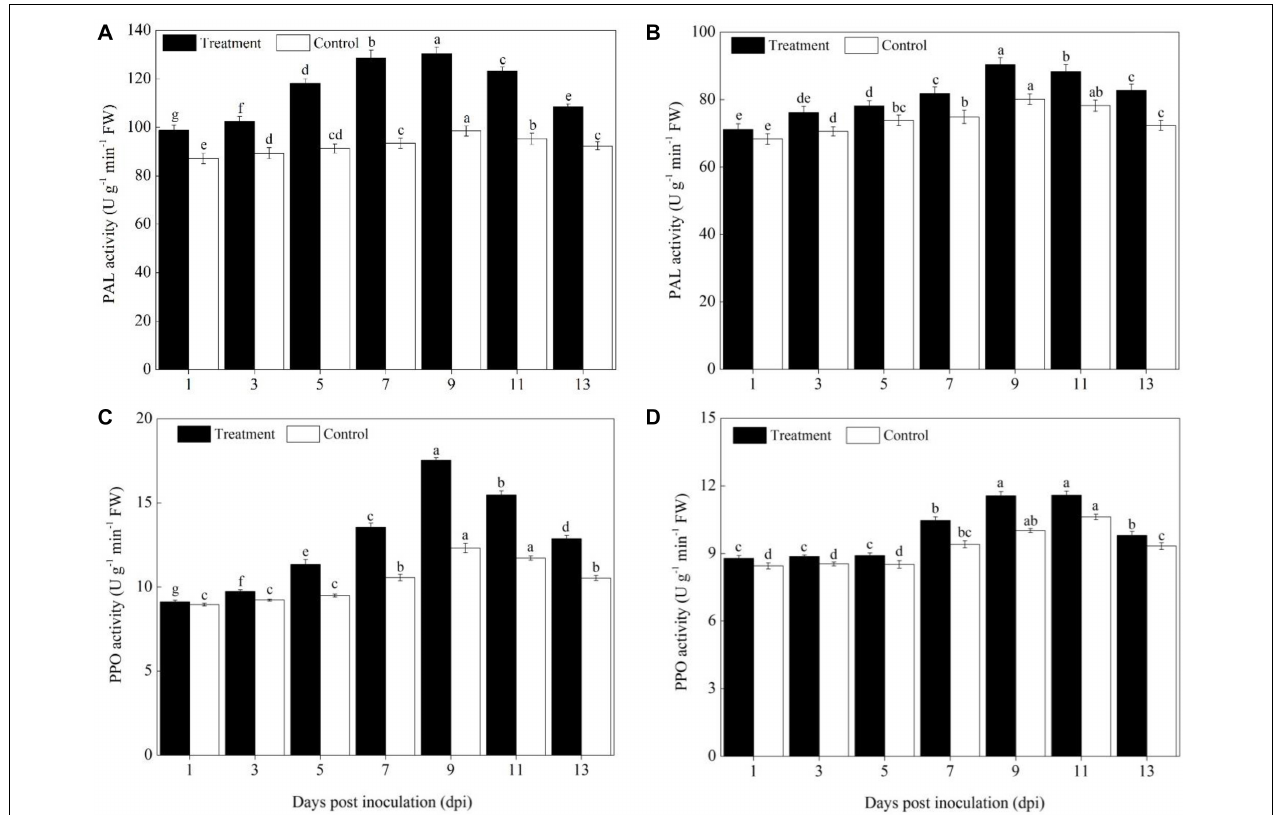
FIGURE 2 | PAL and PPO activity in the leaves of Sixing F 1 and Jin 12 F 1 at different time points after inoculation with Podosphaera xanthii. (A) The PAL activity in the leaves of Sixing F 1 ; (B) the PAL activity in the leaves of Jin 12 F 1 ; (C) the PPO activity in the leaves of Sixing F 1 ; and (D) the PPO activity in the leaves of Jin 12 F 1 . The line bars represent the standard errors of the means. Different letters denote significant difference at the P < 0.05 level by Duncan’s new multiple range test ( n = 12). The treatments are detailed in the footnote of Table 2